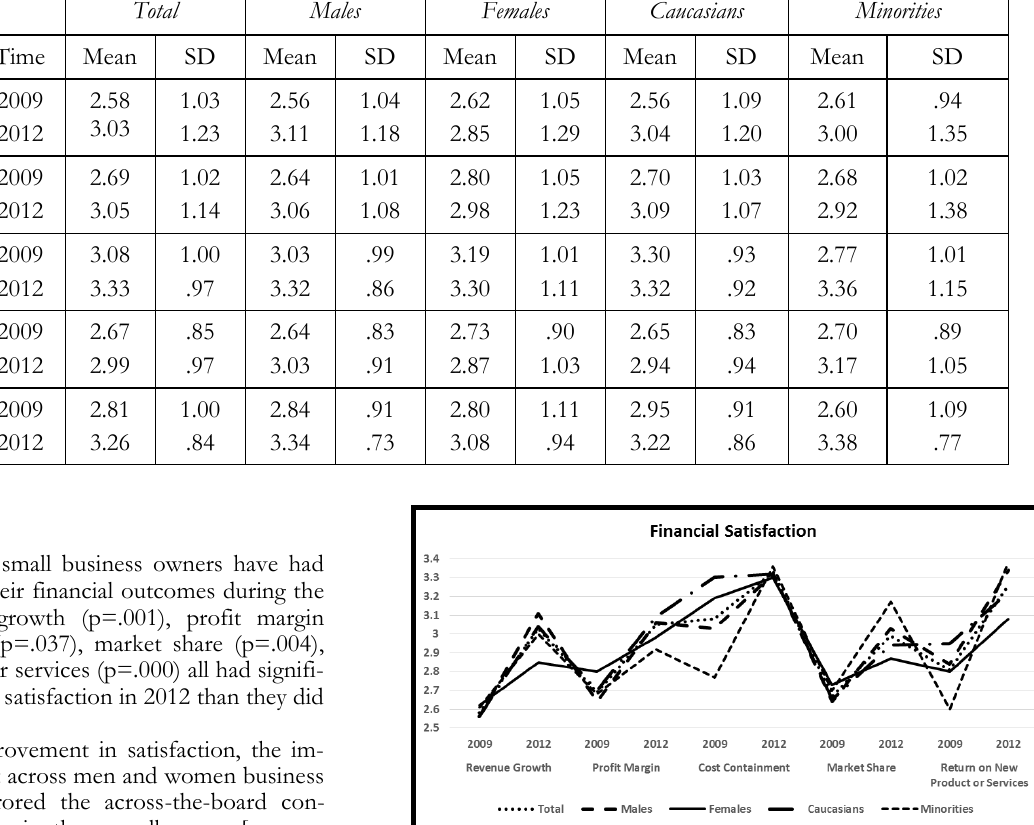
Figure 1: Changes in financial satisfaction for each subgroup between 2009 and